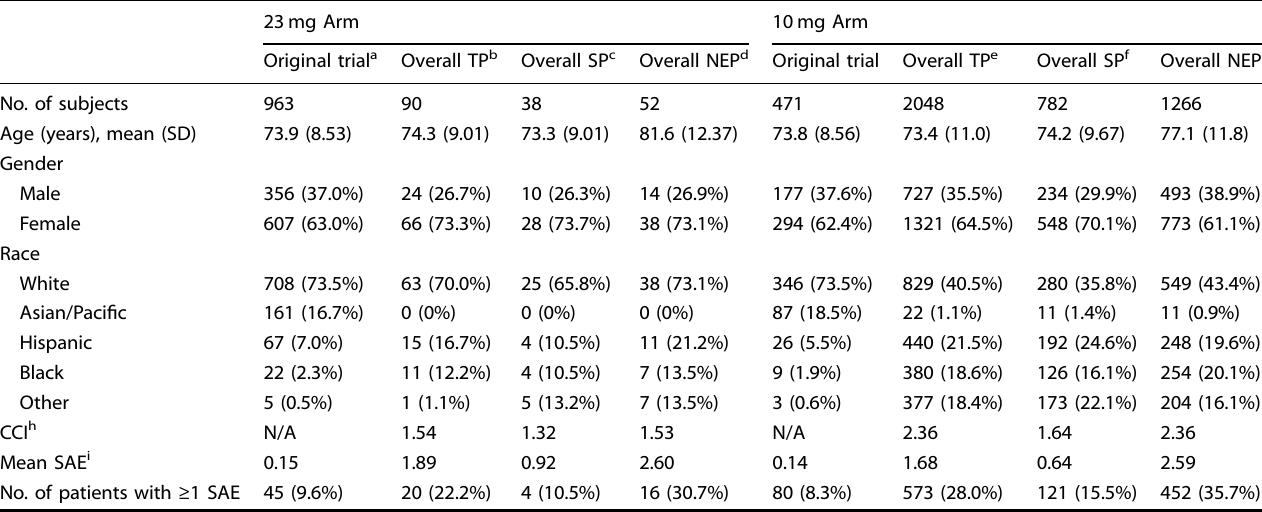
Table 1. Population characteristics and SAE statistics of the target trial vs. TP, SP, and NEP from OneFlorida.